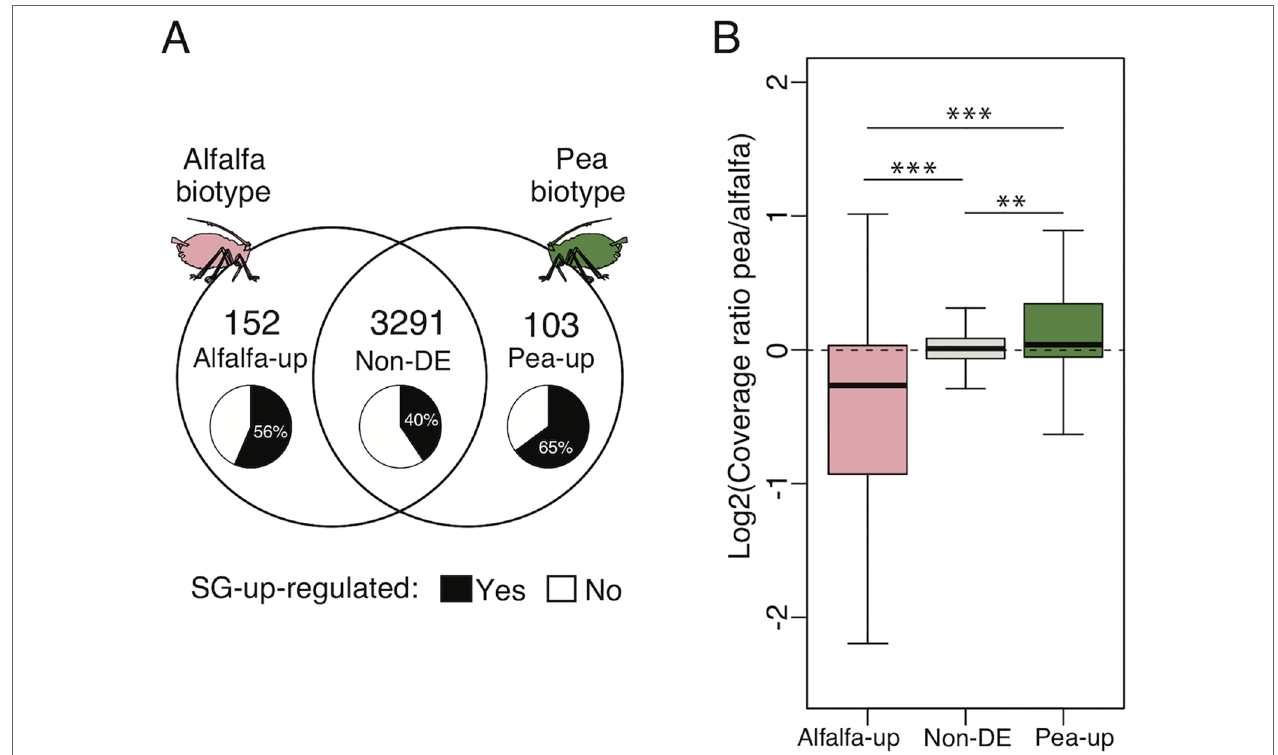
FIGURE 3 | Candidate salivary effector genes in pea and alfalfa biotypes and their genome sequence coverage. (A) The 3,546 candidate salivary effector genes identified from salivary glands of LSR1 and P123 were categorized in three groups based on their DE patterns in the head samples of the alfalfa and pea biotypes. 152 salivary genes were upregulated in the alfalfa biotype, and 103 genes were upregulated in the pea biotype, while 3,291 genes were not differentially expressed. The pie charts indicate the proportions of salivary effector genes showing upregulation in SGs compared with ATs in at least one of the reference aphid lines, LSR1 or P123. (B) Genome sequence coverage ratio (pea/alfalfa) of salivary genes was determined by mapping of pool-seq reads on the LSR1 genome. Asterisks indicate statistical differences after Mann-Whitney tests between alfalfa-up, pea-up, and non-DE salivary effector subsets (** P < 0.01, *** P <